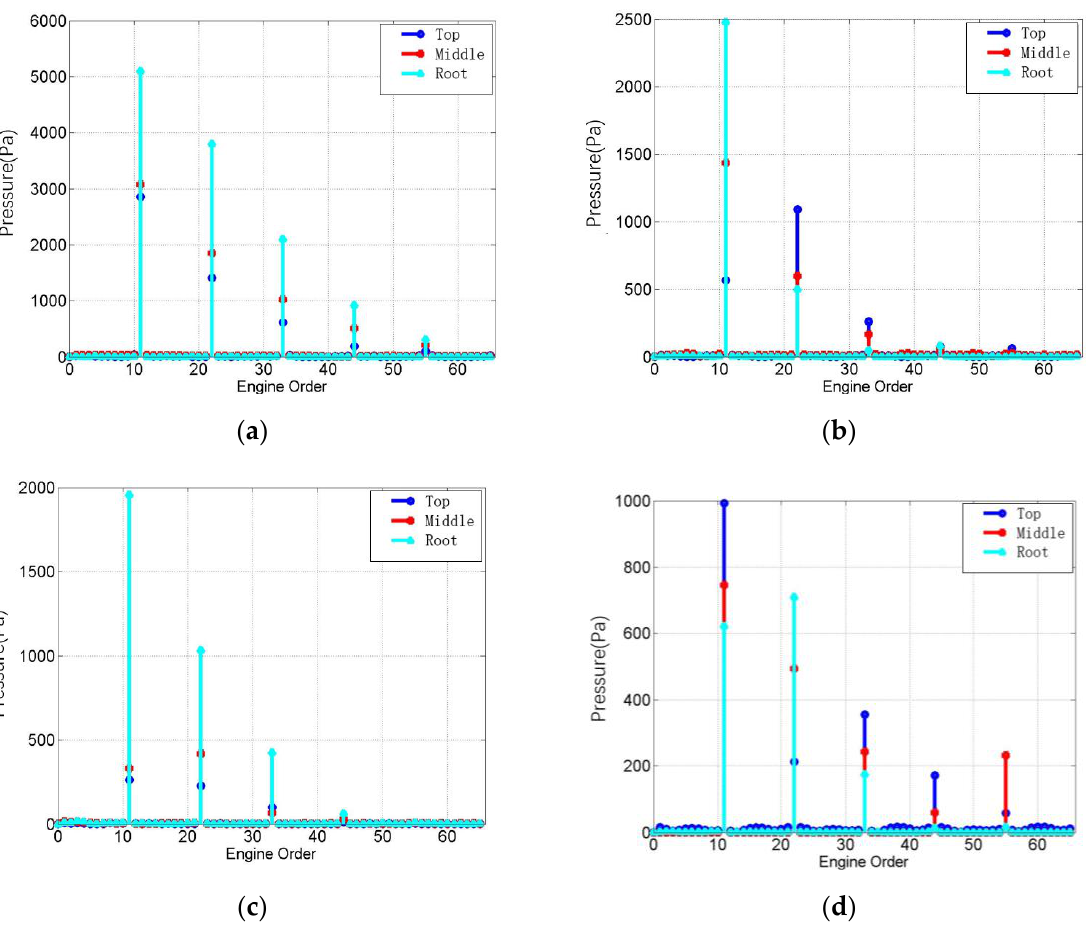
N ): ( a ) leading edge; ( b ) basin; s